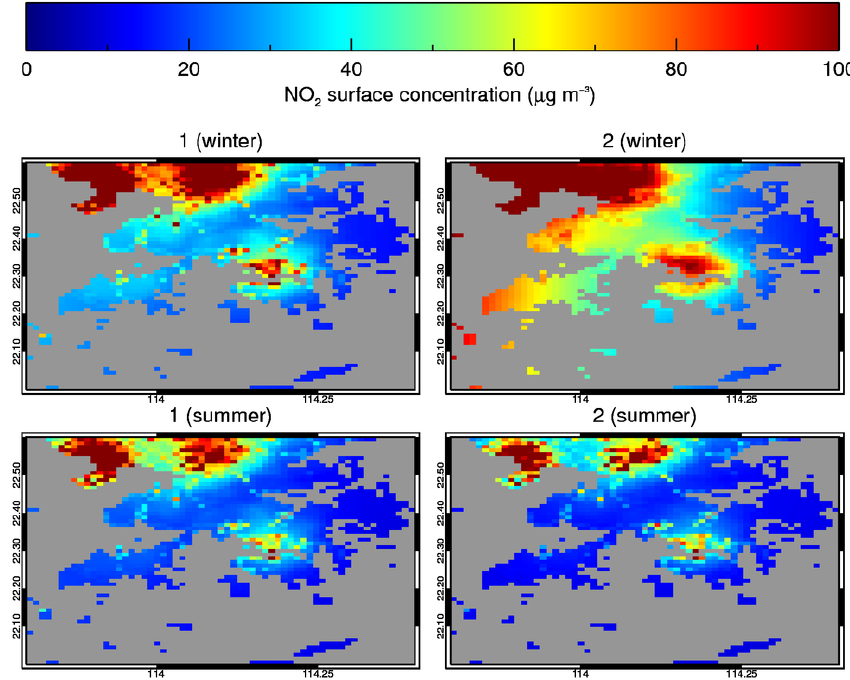
Figure 4. The mean surface NO 2 concentration predicted by models 1 and 2 during winter (November–April) and summer (May–October) between 2005 and